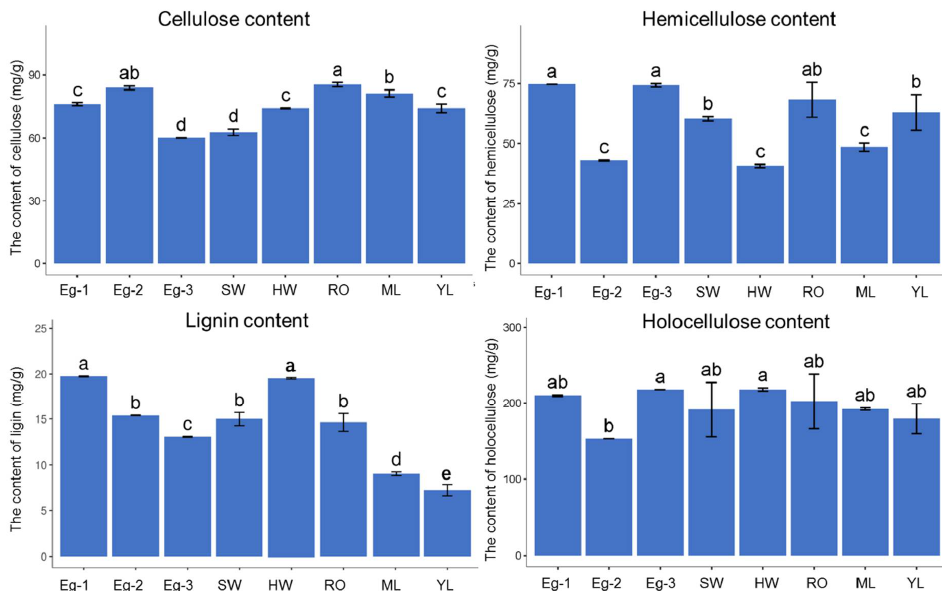
Figure 2. The results of four wood quality indexes of E. grandis in different tissues and at different heights. Eg-1, immature xylem at DBH (diameter at breast height); Eg-2, immature xylem at 11.5 height of trunk; Eg-3, apical shoot meristem; SW, sapwood; HW, heartwood; RO, root; ML, mature leaves; YL, young leaves. The same letters in the figures represent no significant difference, while the different letters represent significant differences. The data were subjected to Duncan’s multiple range test. Error bars represent standard error derived from three replicates.